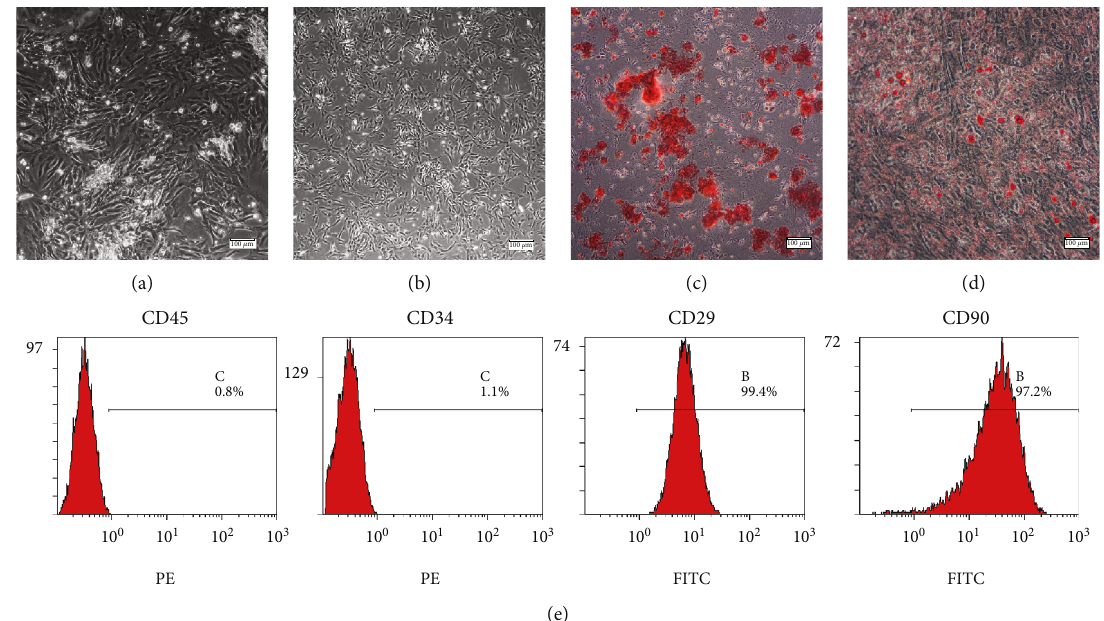
Figure 1: Characterization of ASCs. (a) Primary culture of ASCs. (b)Subculture of ASCs (P2). (c): Mineral nodes stained with Alizarin Red S. (d) Fat droplets stained with Oil Red O. (e) Flow cytometry analysis of ASC surface